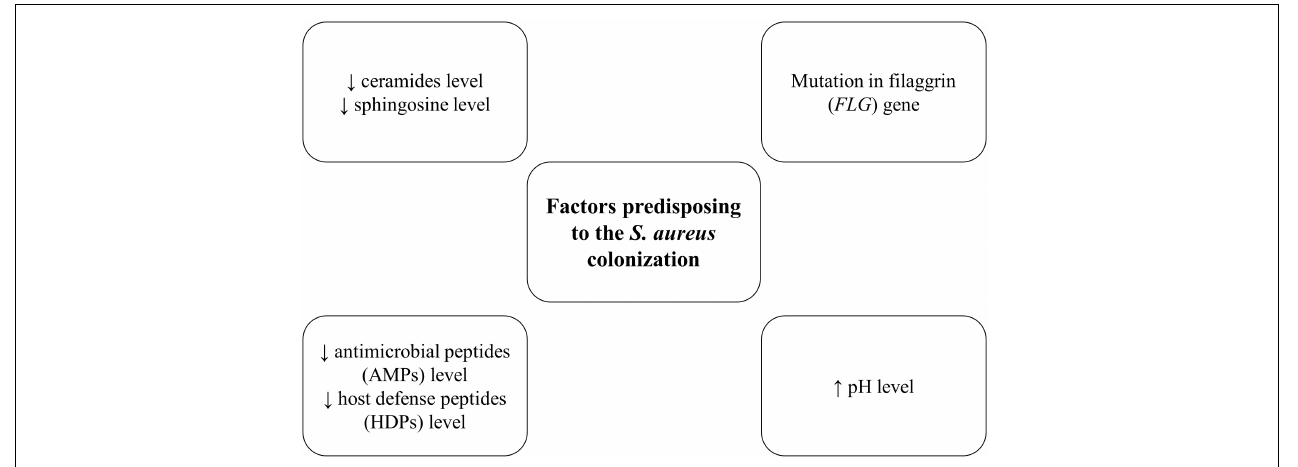
FIGURE 2 | Factors predisposing to the S. aureus colonization.